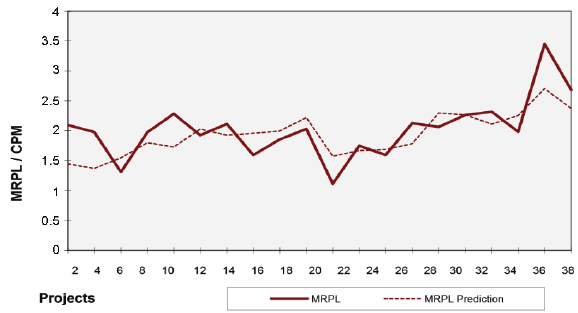
Fig. 3. The estimated values for project time as per the MRPL priority rule in testing set